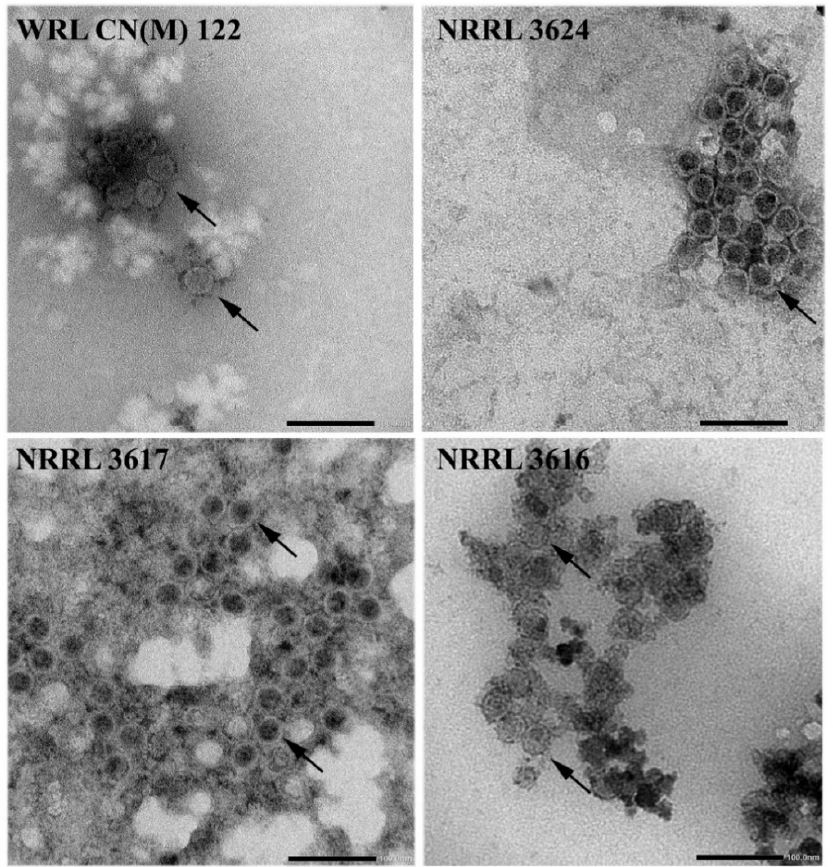
Figure 3. Morphology of virus particles detected in mycovirus-harboring Mucor strains. The virus particles were recovered by ultracentrifugation at 78,000× g for 12 h at 4 °C, which follows with sucrose gradient density centrifugation. Purified virus particles were negatively stained with 2% uranyl acetate in 50% ethanol for 5 min (3 times) and examined under a JEM-1400 Flash transmission electron microscope. VLPs about 33–36 nm in diameter were detected in the examined Mucor strains. The detected VLPs are indicated by black arrows.